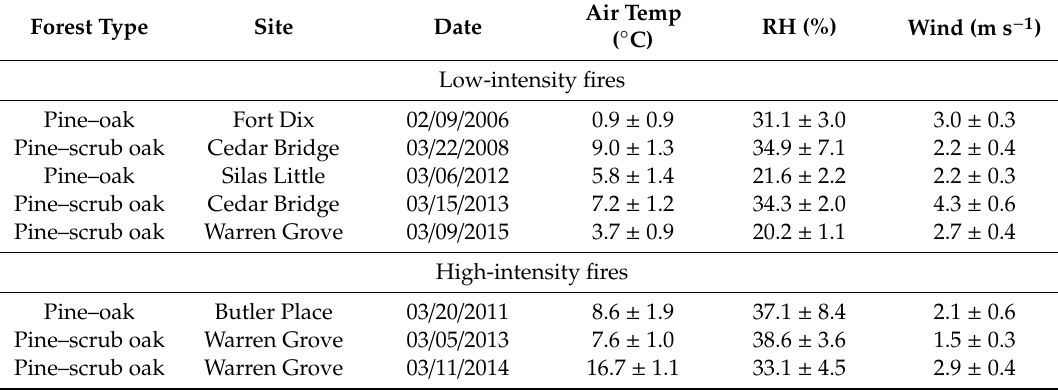
Table 2. Meteorological conditions during the eight prescribed burns conducted in the New Jersey Pinelands National Reserve. Data are forest type, site location, date of the prescribed fire, and mean ambient air temperature, relative humidity and wind velocity measured above canopy (12.5 to 19.5 m height) from 12:00 to 16:00 LT (mean ± 1